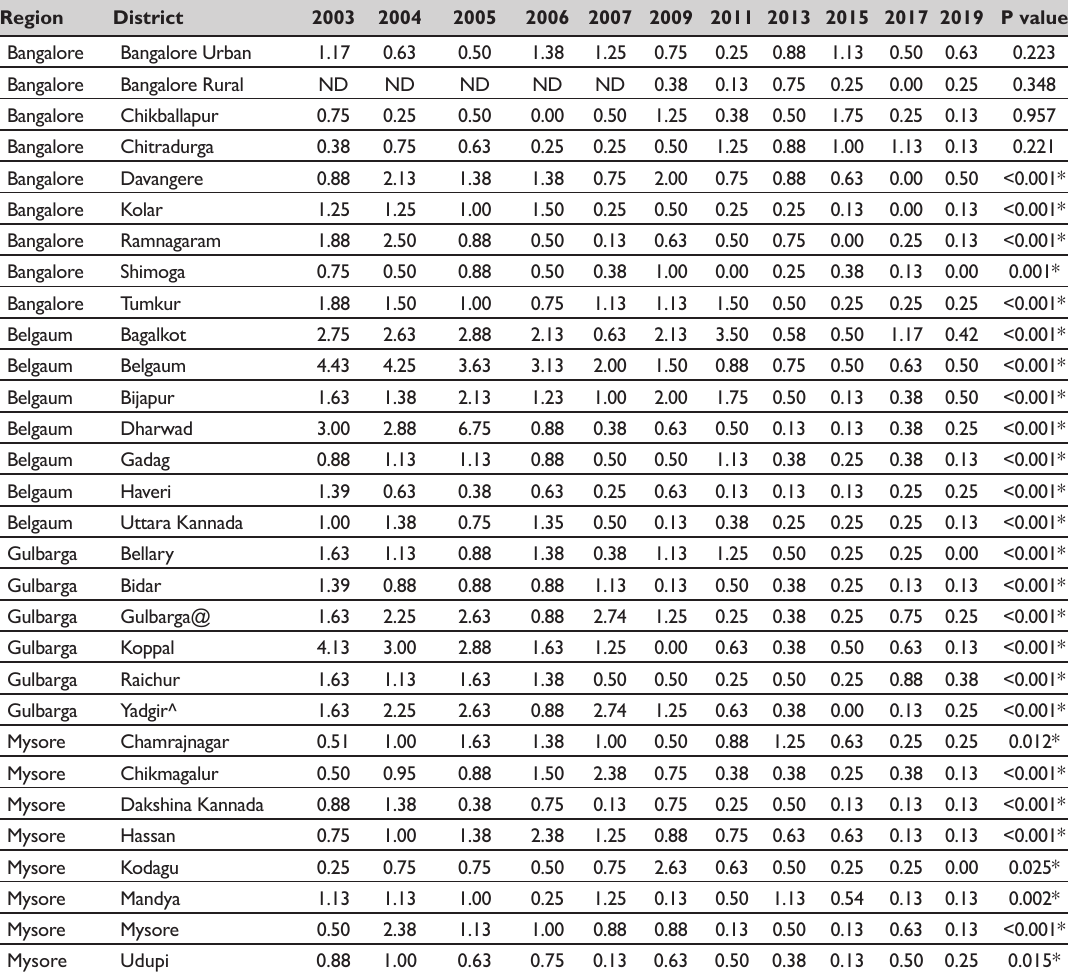
Table 2: Prevalence trend of district level HIV prevalence (%) among pregnant women in Karnataka, 2003-2019 Region